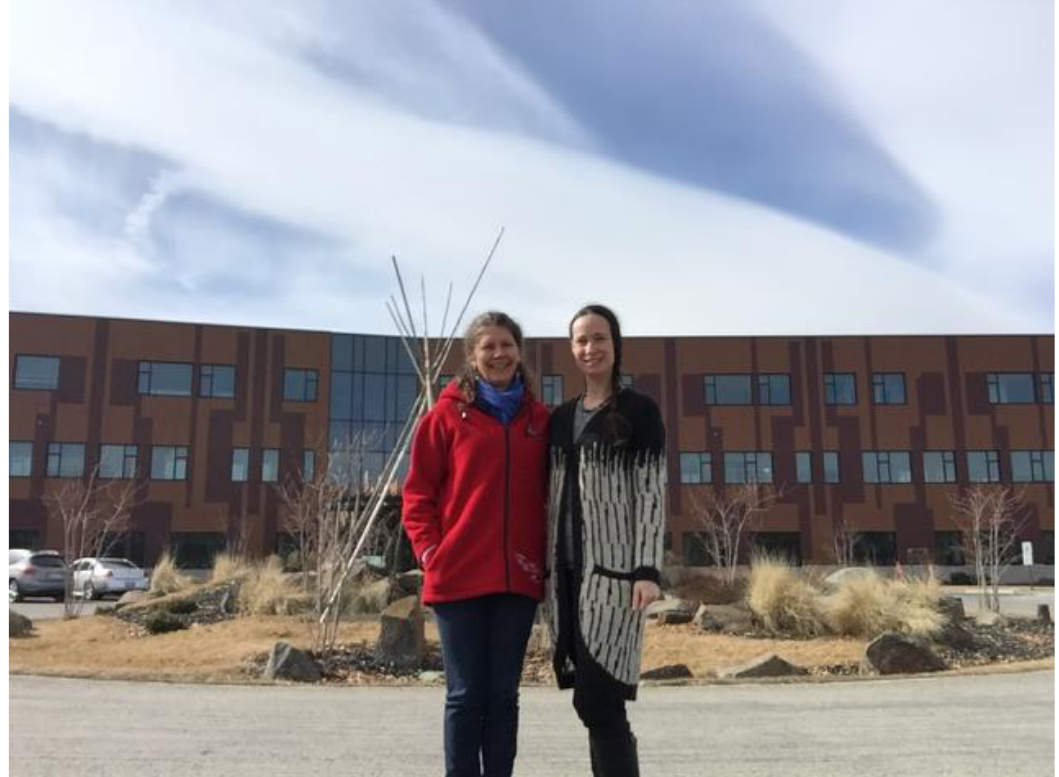
Figure 5: Author with colleague Jessica Morin (another Selkirk College employee at the time) in front of the offices of the Colville Confederated Tribes (CCT) during a visit in 2018 where approval was sought from CCT Council and members for a course that would introduce Indigenous people in the Region Selkirk College operates, including Sinixt people. Courtesy: Theresa